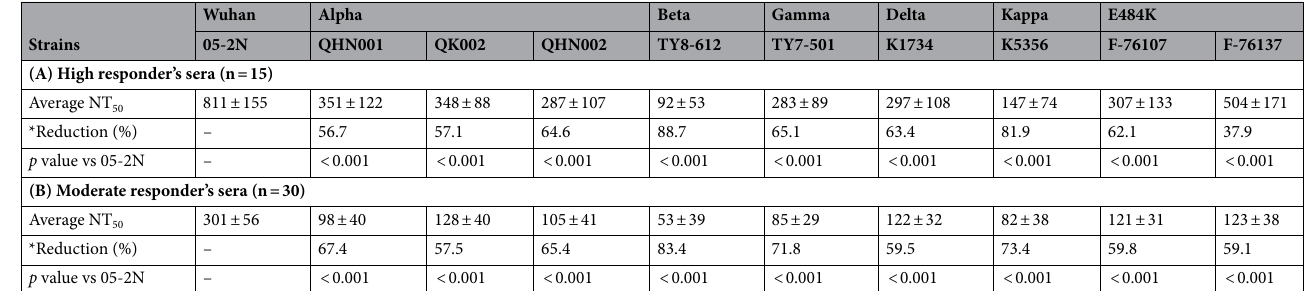
Table 2. Reduction of neutralization against VOCs and VUM by day-60 sera from high and moderate responders compared to those against wild-type Wuhan strain. Average NT 50 titers of day-60 sera of high (n = 15) or moderate (n = 30) responders against SARS-CoV-2 05-2N and various variants are